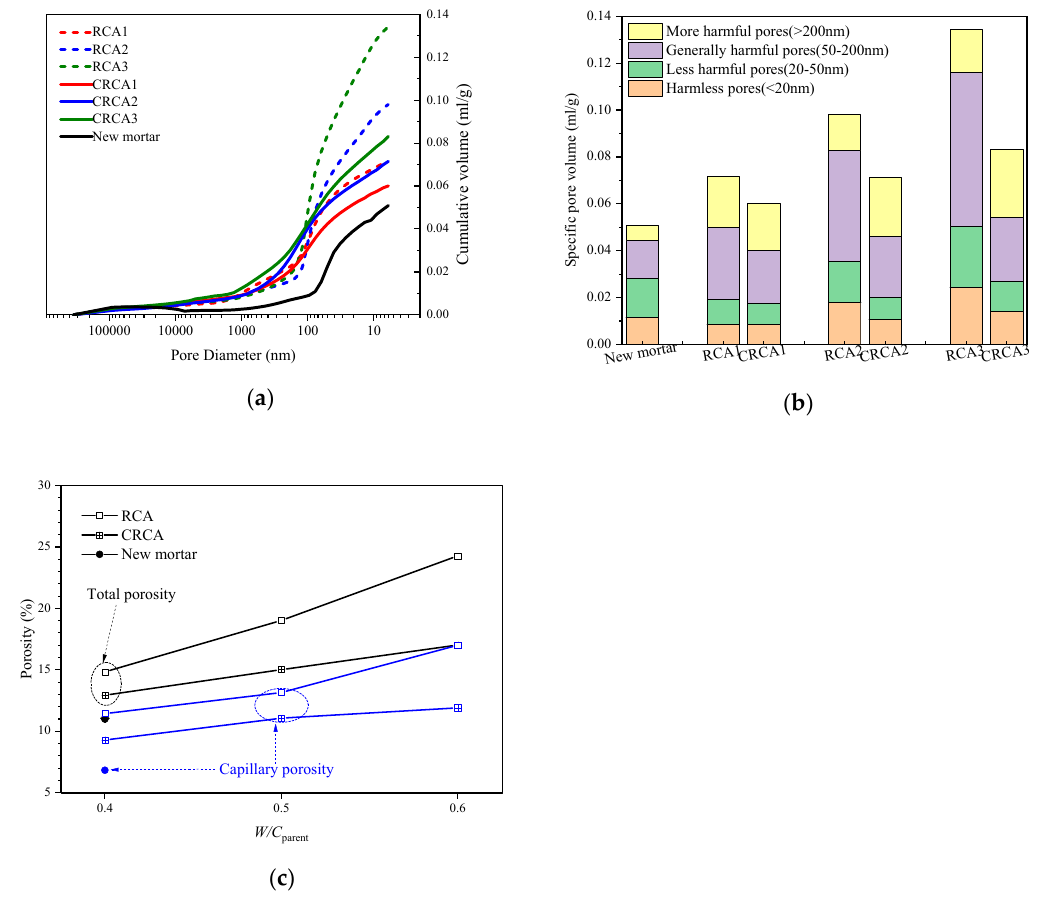
Figure 7. Pore structure of mortar in concrete: ( a ) cumulative curves of the pore size distribution, ( b ) pore volume distribution, and ( c ) porosity and capillary porosity of mortar. According to the e ff ect of di ff erent pore size on chloride di ff usion in concrete [4], pores in